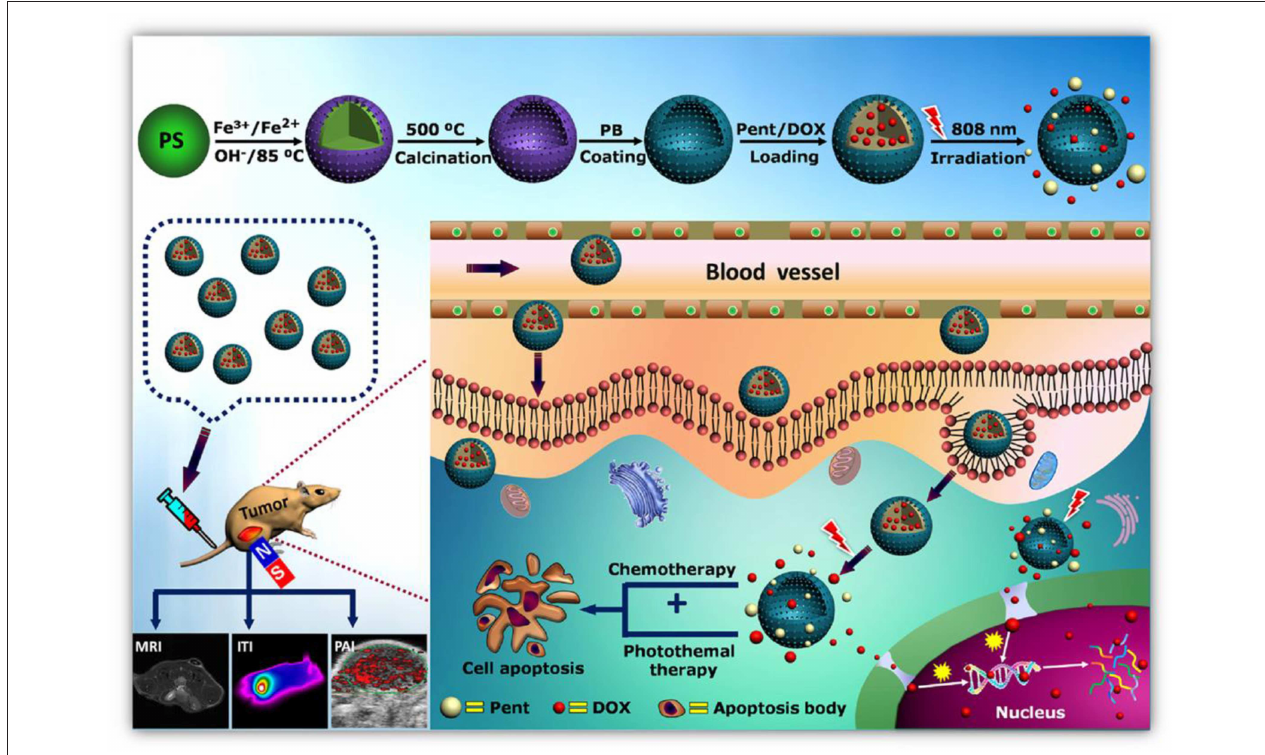
FIGURE 10 | Controlled delivery of anti-tumor drug with a new design incorporating a phase-change material in magnetic nanoparticles allowing chemo-photothermal combined tumor therapy with multimodal tumor imaging [adapted and modified from: http://www.advancedsciencenews.com/pent-drug-delivery-tumor-therapy- trimodal-imaging (accessed on July 07, 2018, 2200 PST)].